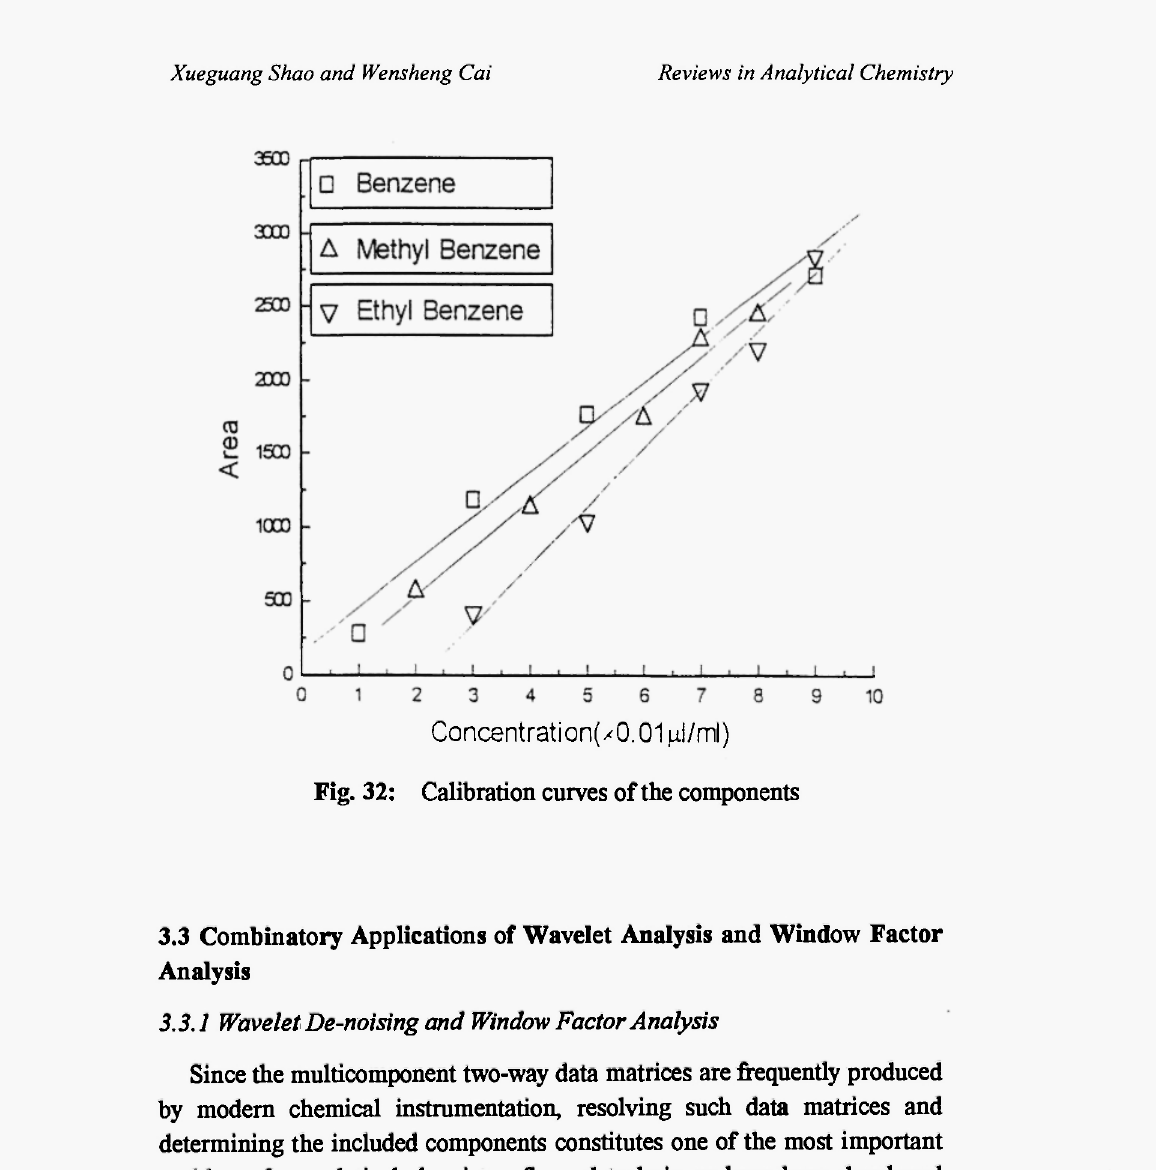
Fig. 32: Calibration curves of the